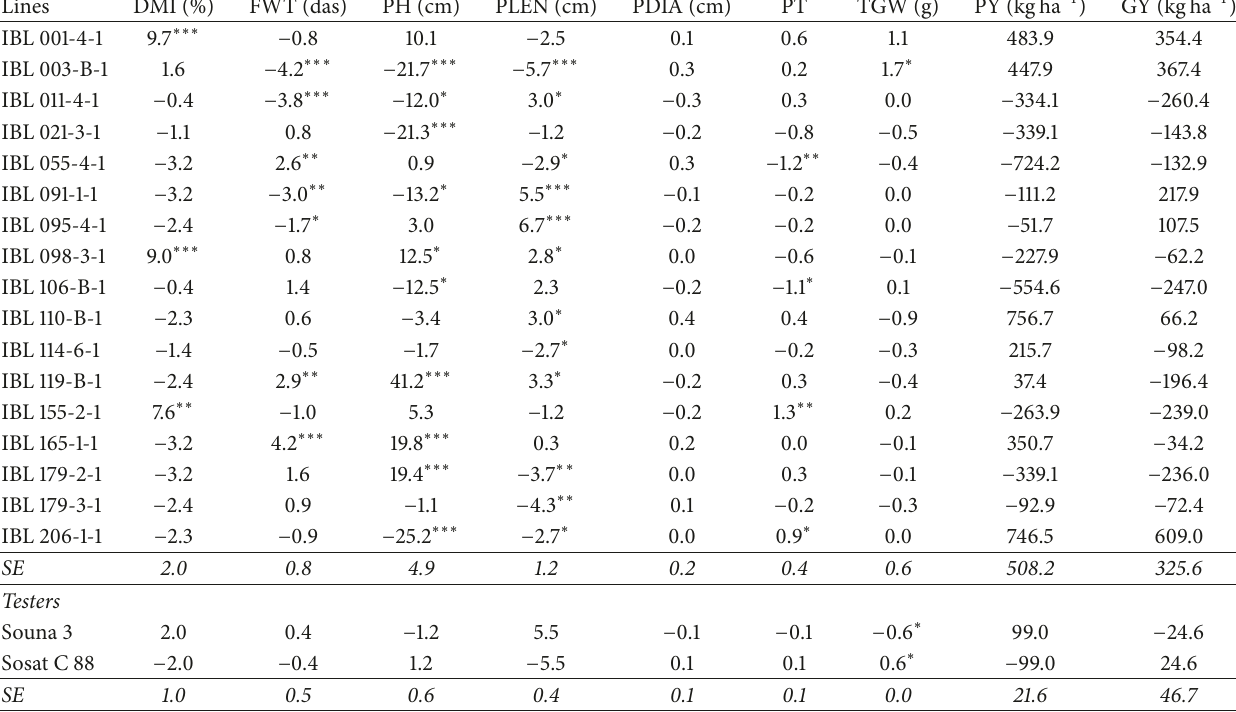
Table 6: Estimates of GCA effects of lines and testers evaluated across the two